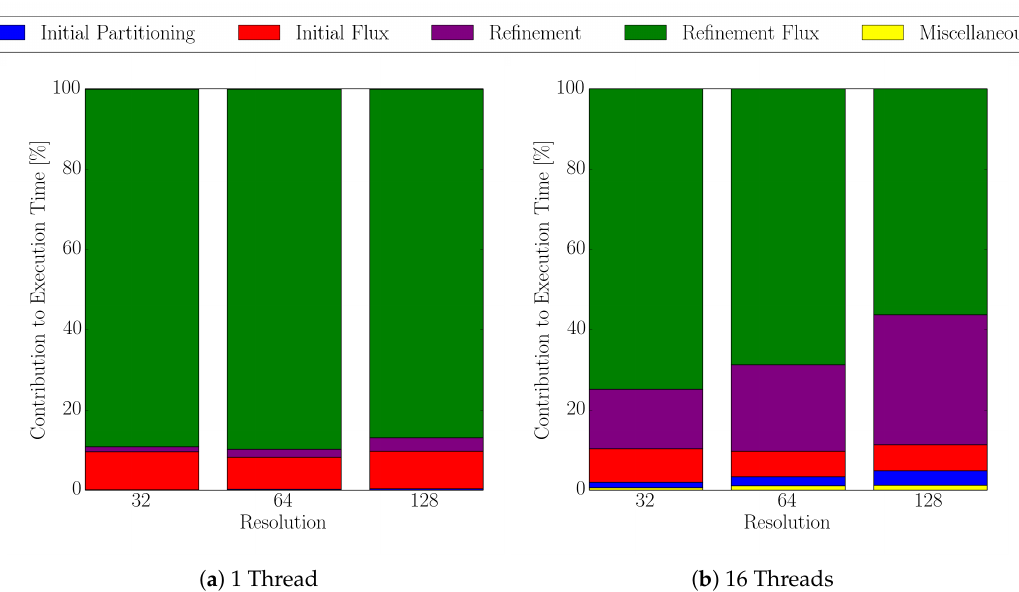
Figure 11. Execution times and speedups at various level-set resolution for the dense and sparse flux calculation approach.